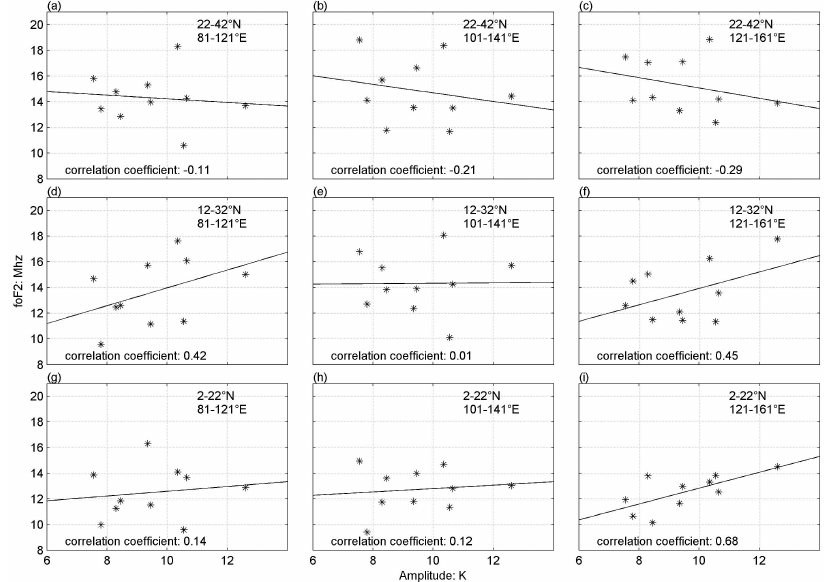
Fig. 11. The scatter plot of the daily maxima of the foF2 and the amplitude of the gravity wave in 9 areas for the Pingtung Doublet earthquake. earthquake (Fig. 12e), although the corresponding correla- tion coefficient is only 0.43 (Fig. 13e). This moderate cor- relation means that some other possible mechanisms might also be participating in generating the variation of foF2, or the enhancement of the amplitude of the wavy structures with a vertical wavelength of 20–30 km in Tn height profiles does not always efficiently modify the E-region